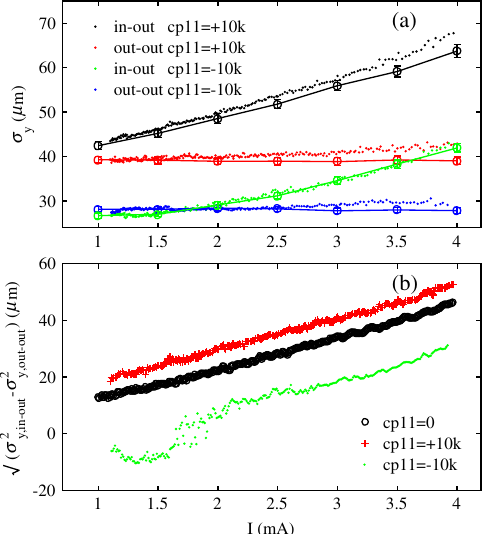
FIG. 8. The measured vertical beam size σ y as a function of bunch current with top scraper inserted (black crosses) or retracted (red dots) for two e þ lattices: (a) lat þ ð 0 Þ and (b) lat þ ð − 54 Þ . The simulated results are the diamonds and circles.